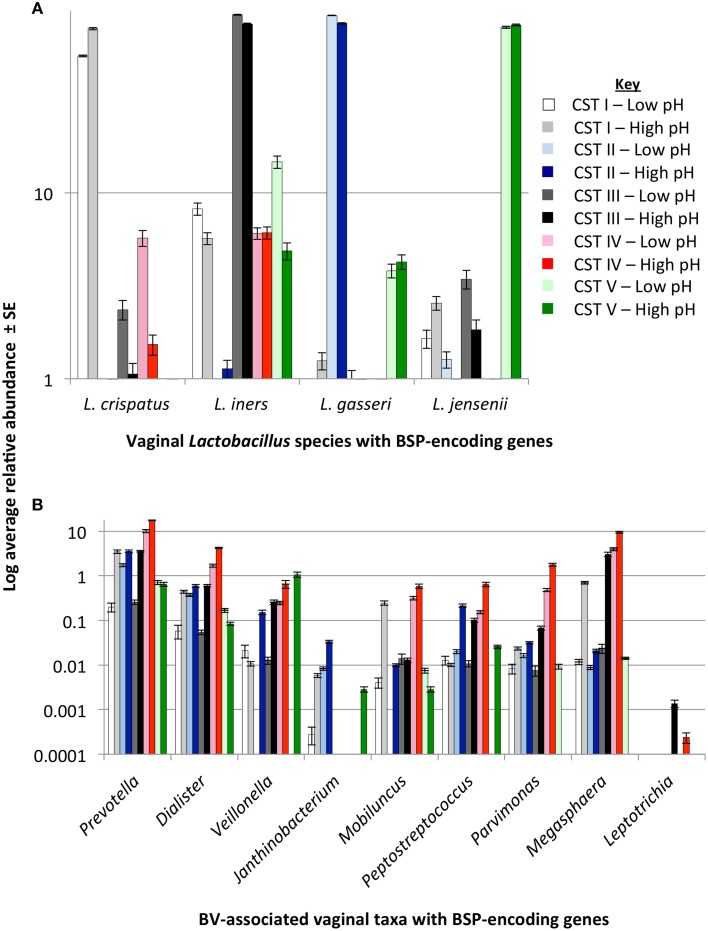
BSP-encoding gene presence stratified by community state type (CST) and pH. Bar charts display average log scaled relative abundances ± standard error (SE) of bacterial taxa in the vaginal microbiome of healthy women with biogenic amine-synthesizing proteins (BSP) encoding genes as identified from GenBank. Taxa are grouped by Lactobacillus species (A) and BV-associated anaerobes (B) shown in relation to CST and vaginal pH. Abundance data was taken from Ravel et al. (2011). Significant differences between groups are shown in Table 2.